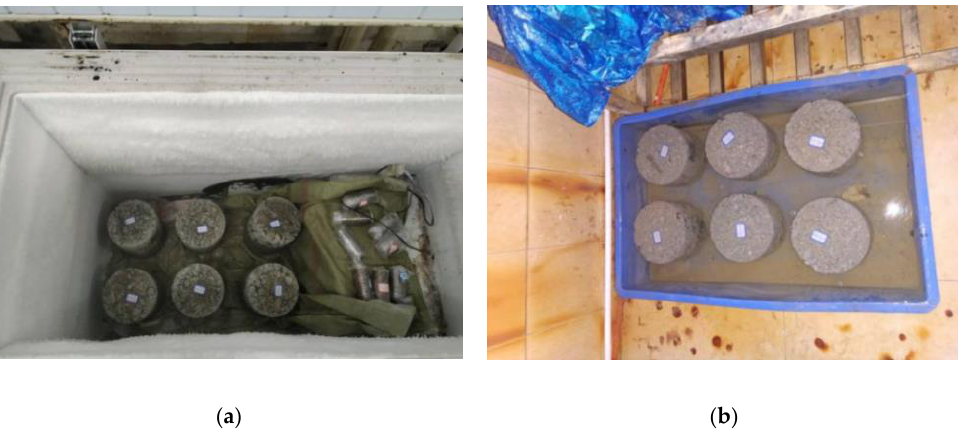
Figure 6. Freeze–thaw cycle and water-stability test: ( a ) freeze–thaw test; ( b ) water immersion.